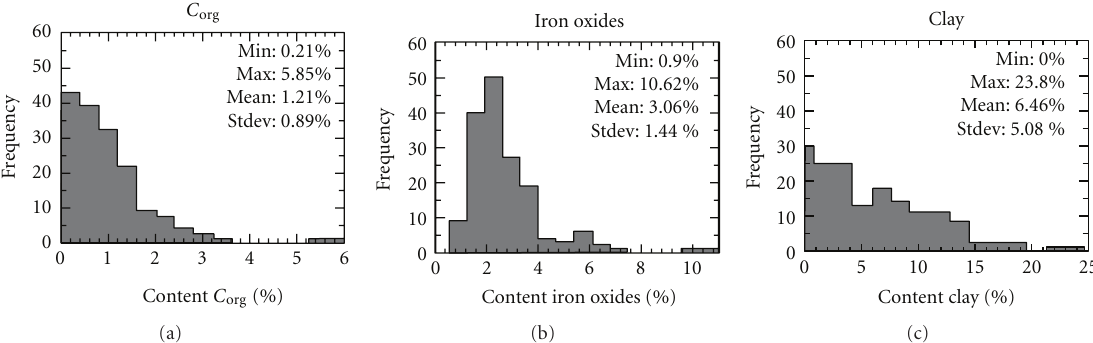
Figure 3: Histogram distribution with statistical parameters for 164 topsoil samples collected in the Thicket Biome, South Africa, analyzed for soil organic carbon, iron oxides, and clay